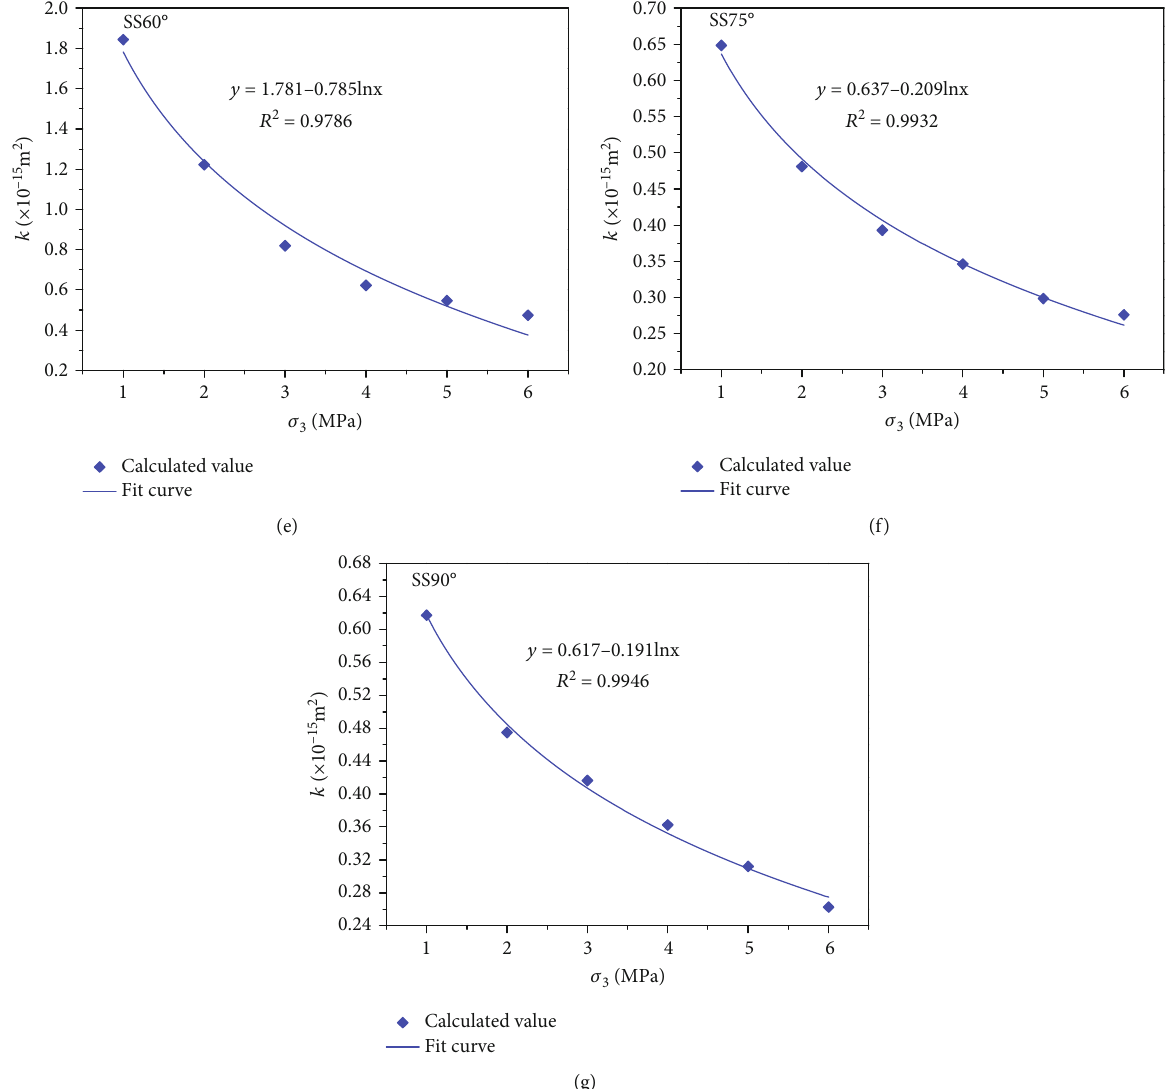
ff erent dip 3 for samples with di